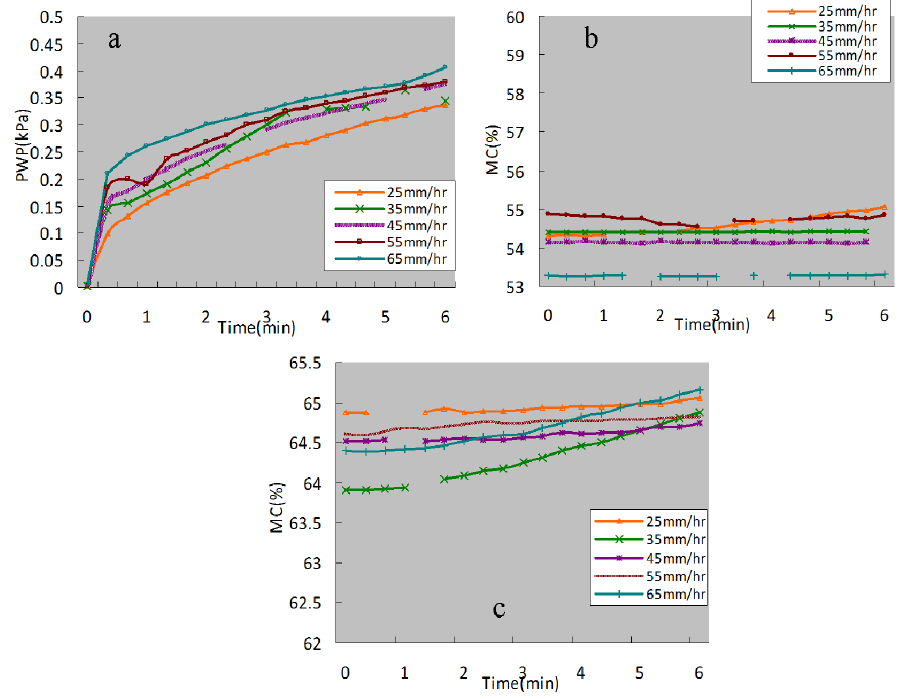
Figure8. Hydrological monitoring data: ( a ) p1, ( b ) m1 and ( c ) m2. Figure 8. Hydrological monitoring data: ( a ) p1, ( b ) m1 and ( c ) m2.